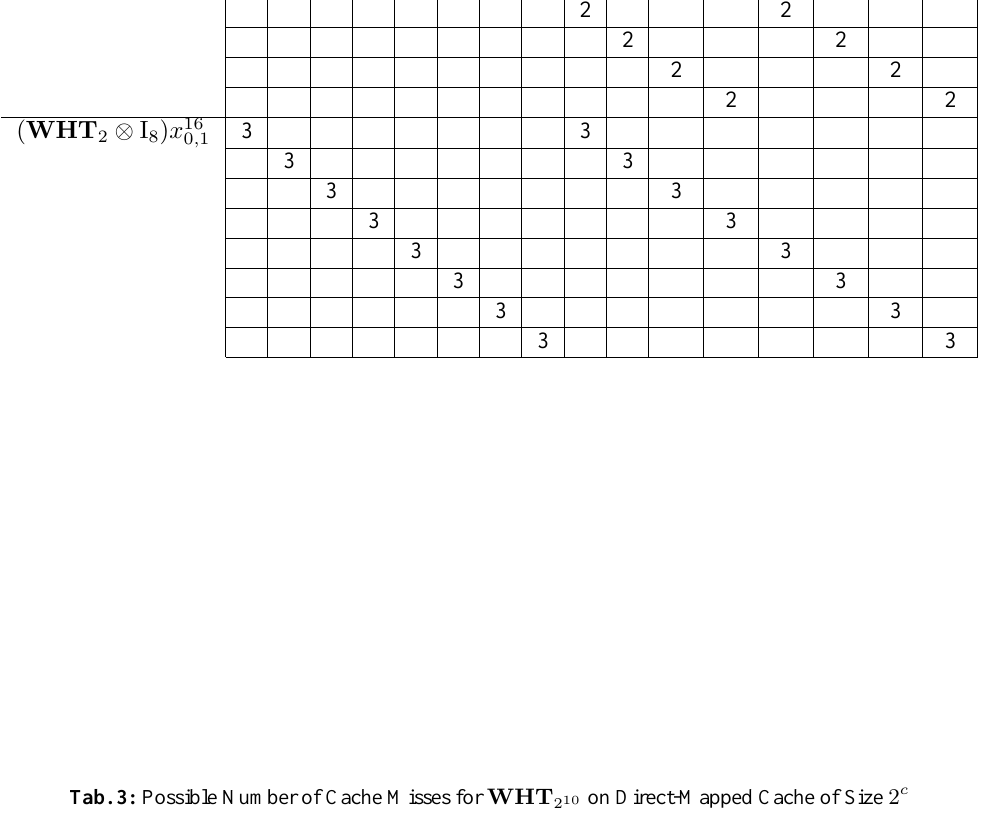
on Direct-Mapped Cache of Size 2 2 10